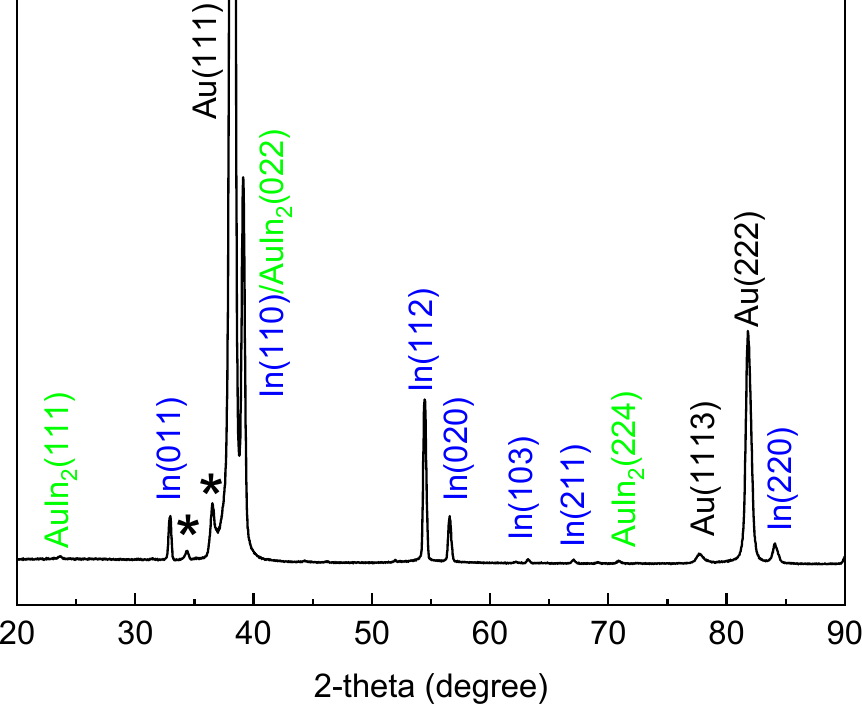
Figure 3. X-ray diffraction (XRD) of indium deposit on Au substrate from 0.1 mol/L InCl 3 in [Py 1,4 ]TFSI.